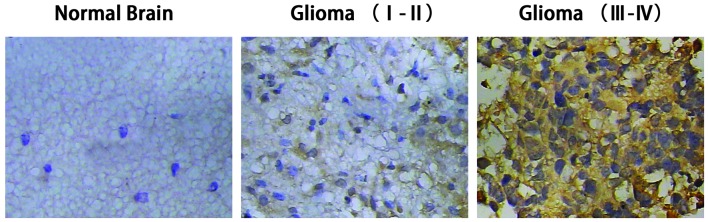
Immunohistochemical analysis of ADAM17 immunoreactivity in normal brain and glioma tissues (magnification, ×400). Gliomas with high grades exhibited stronger ADAM17 protein expression compared with gliomas with lower grades and the normal brain tissues (P<0.05). ADAM17, a disintegrin and metalloproteinase-17.